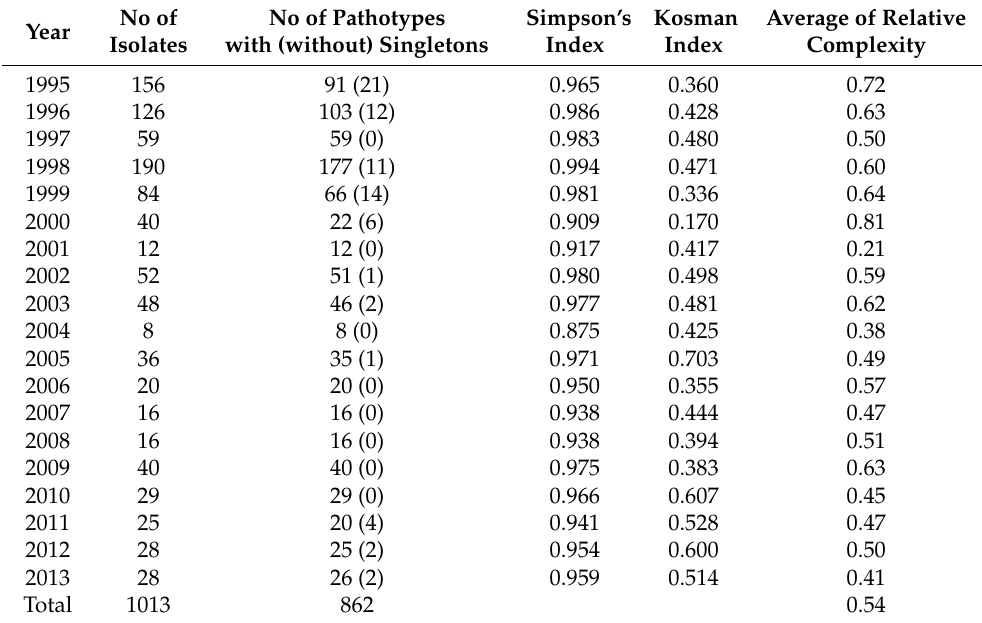
Table 2. Response of the Blumeria graminis f. sp. tritici isolates on wheat differentials during 1995–2013.